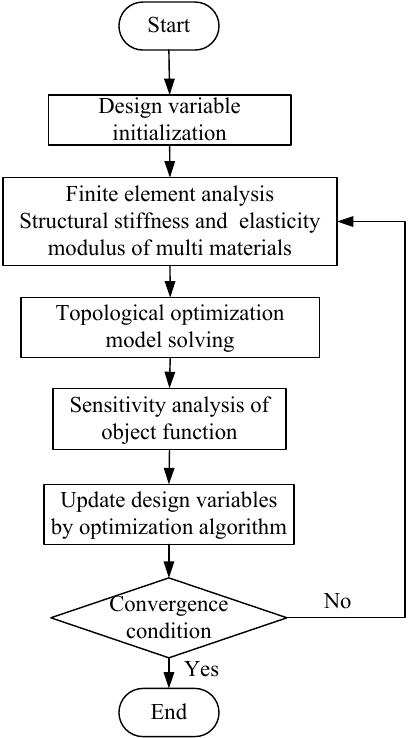
Figure 3. Flowchart of the algorithm.